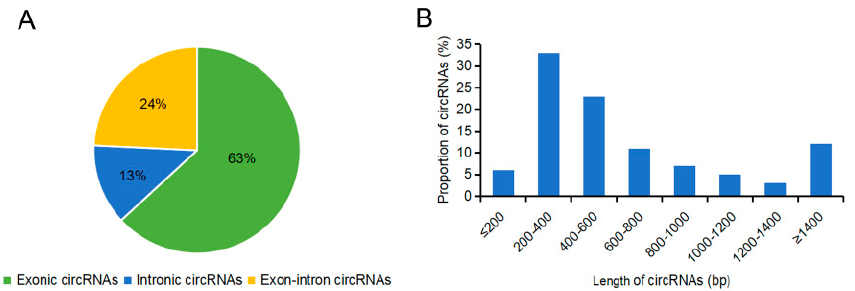
Figure 5. Features of circRNAs identified in Bcajh97-01B (fertile line) and Bcpol97-05A (sterile line) of Brassica campestris . ( A ) Types of circRNAs. ( B ) Distribution of the length of circRNAs.